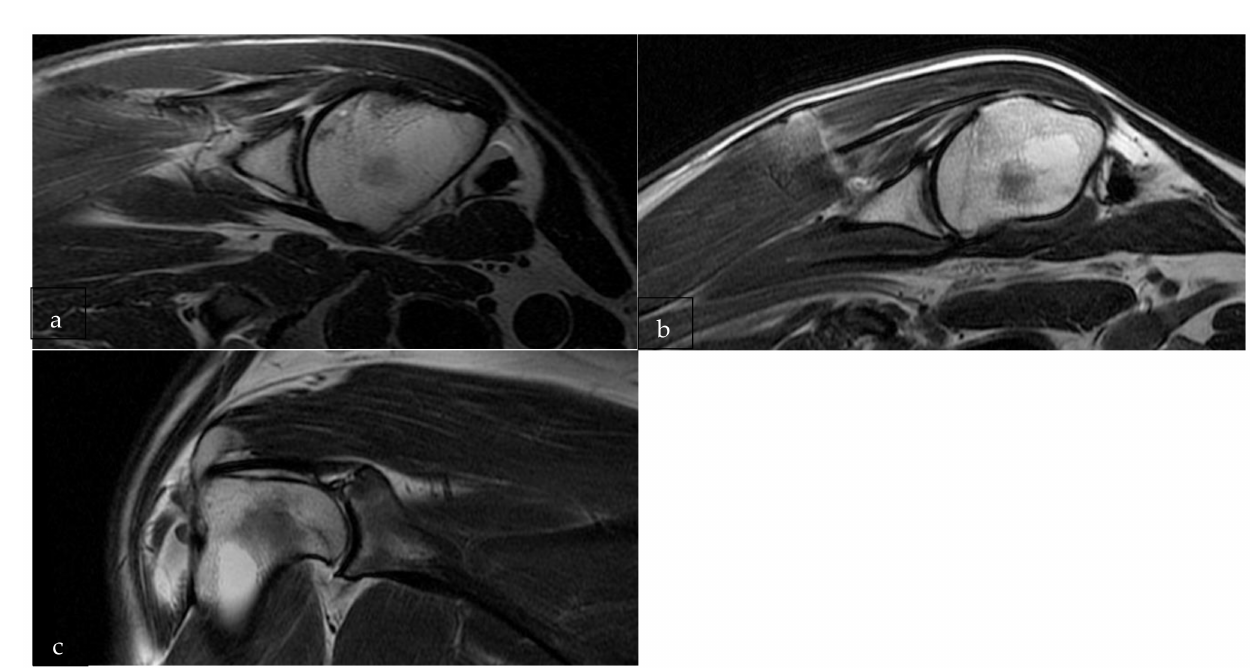
Figure 3. ( a – c ) Loss of cartilage surface area in the glenoid. ( b , c ): BML of the superior aspect of the glenoid.